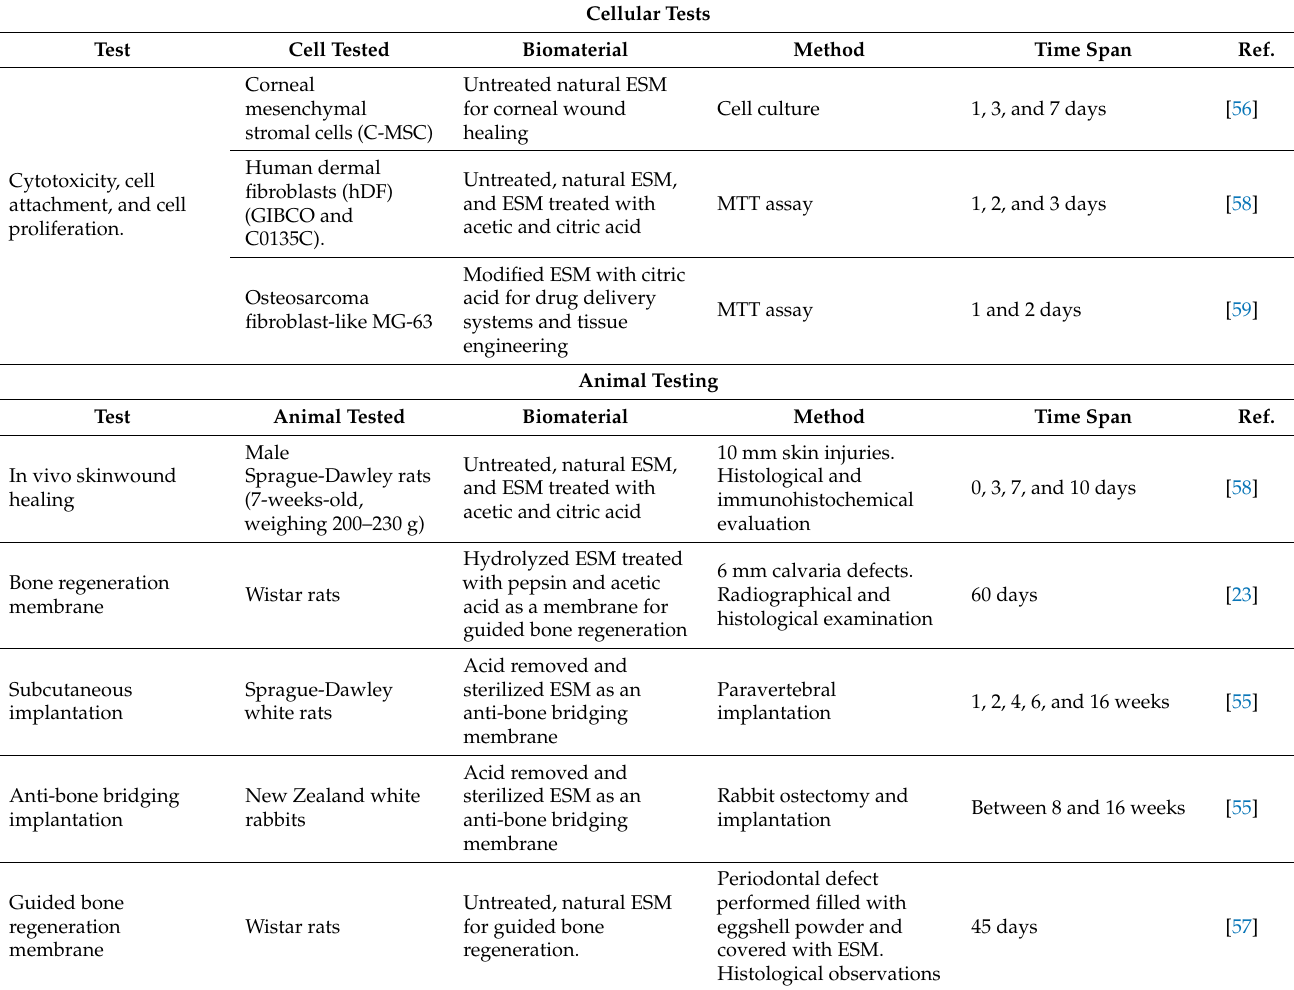
Table 5. Biological tests performed with eggshell membrane. The cellular and animal tests are described. Cellular